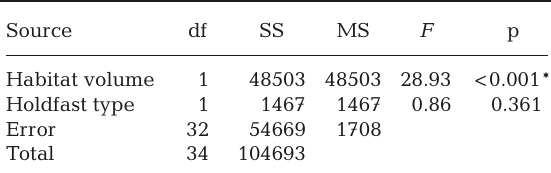
Table 1. ANCOVA data from Laminaria digitata number of individuals vs. holdfast types (benthic and suspended) with habitat volume as a covariate. *Significant difference at p <